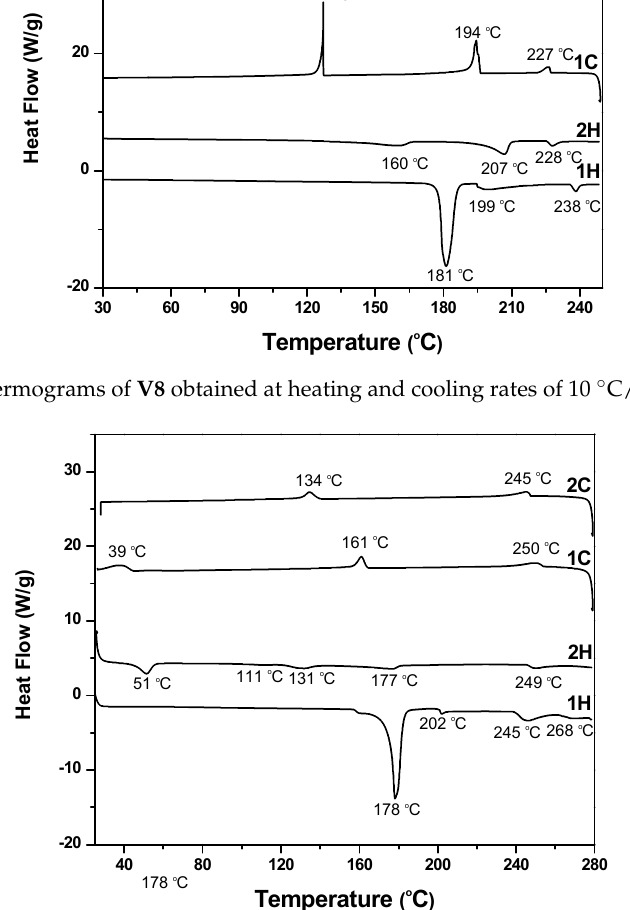
Figure 5. DSC thermograms of V9 obtained at heating and cooling rates of 10 °C/min in nitrogen.